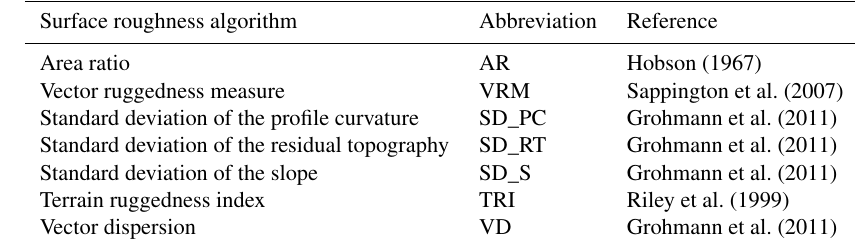
Table 1. Summary of the seven algorithms used to compute the terrain roughness.